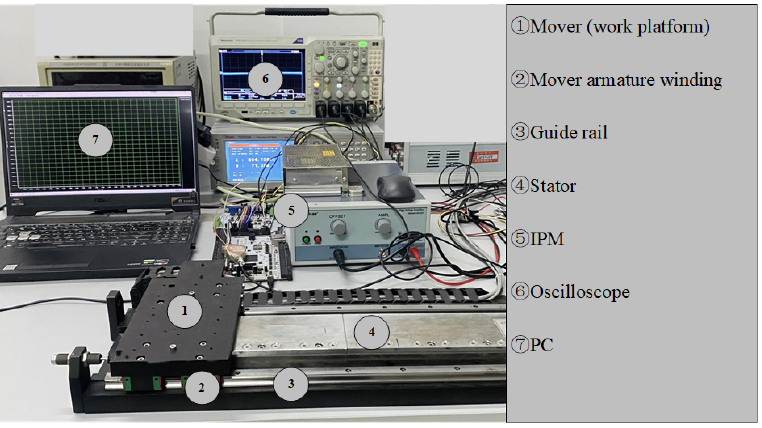
Figure 11. Experimental diagram.